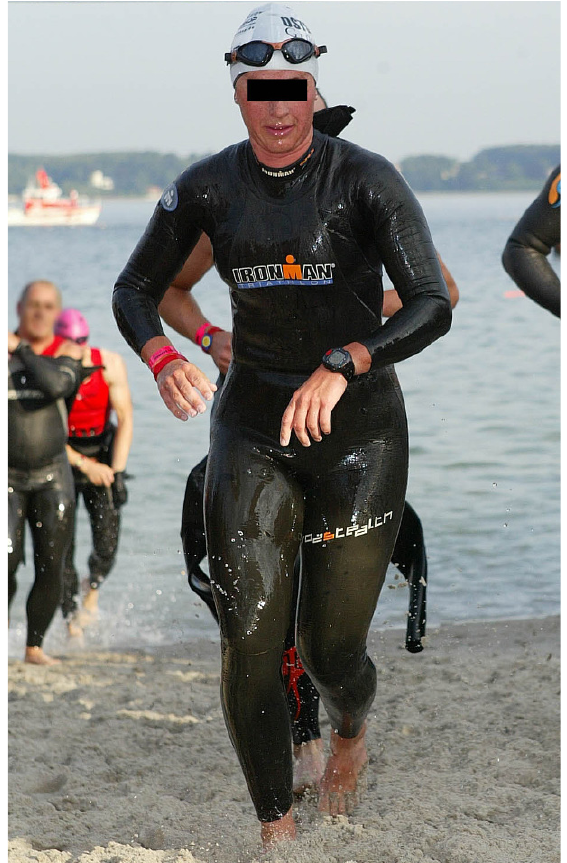
Figure 1. 30 year old female patient suffering from postprandial and sports related spasmodic pain in the upper abdomen. Used with permission of the